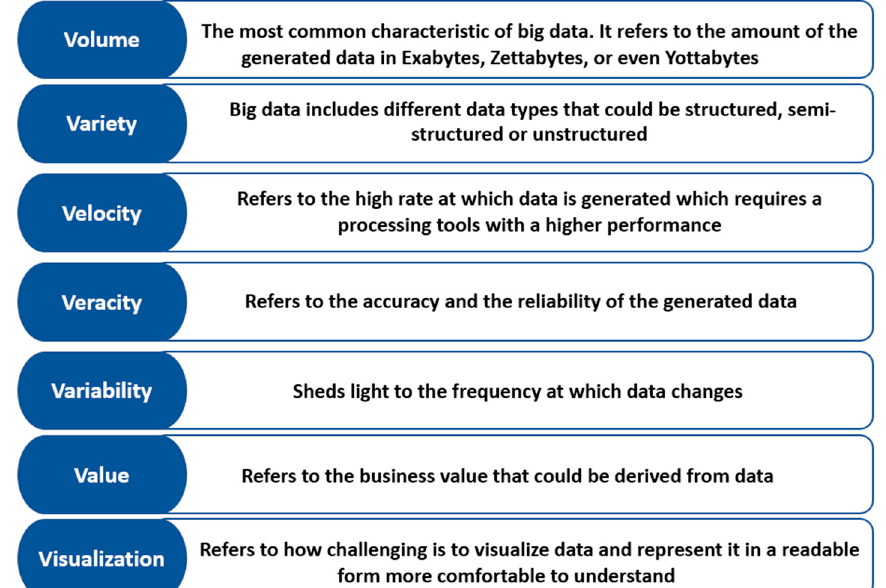
Figure 1. The 7V’s of Big Data.